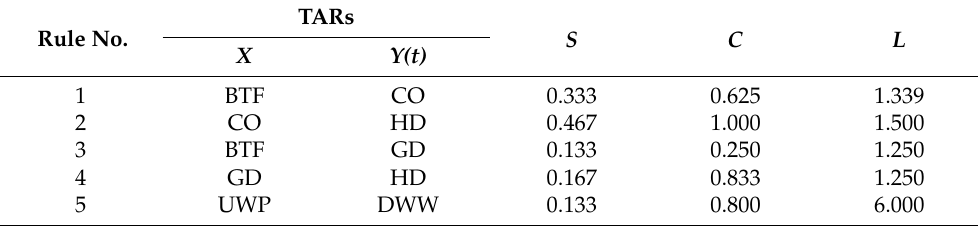
Table 7. TAR results for bulk